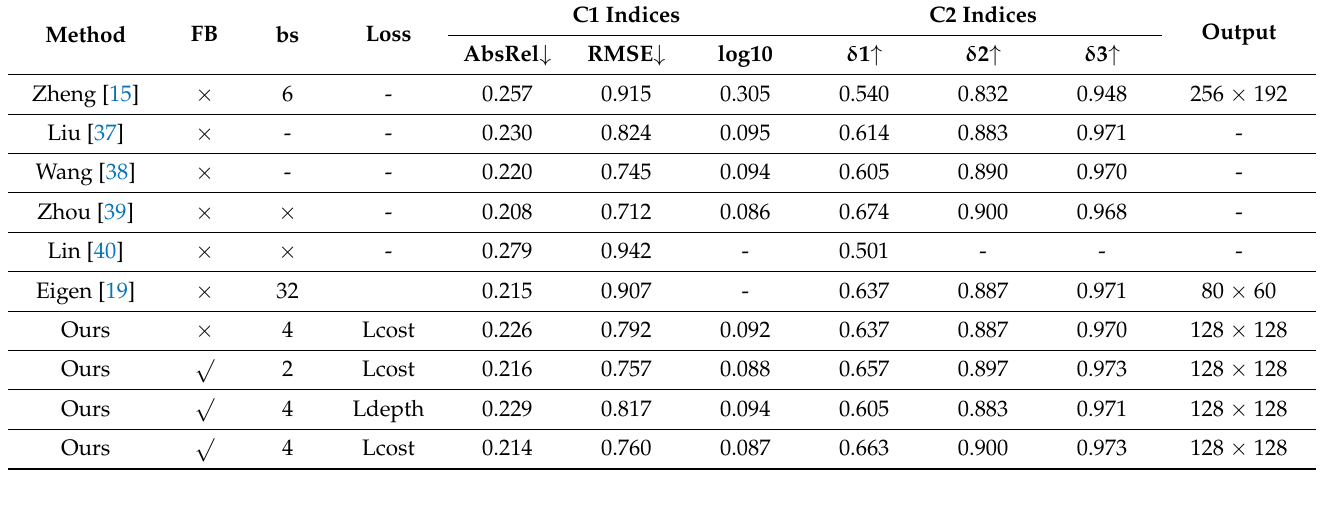
Table 1. Comparison of C1 and C2 indices of different methods on NYU Depth V2.